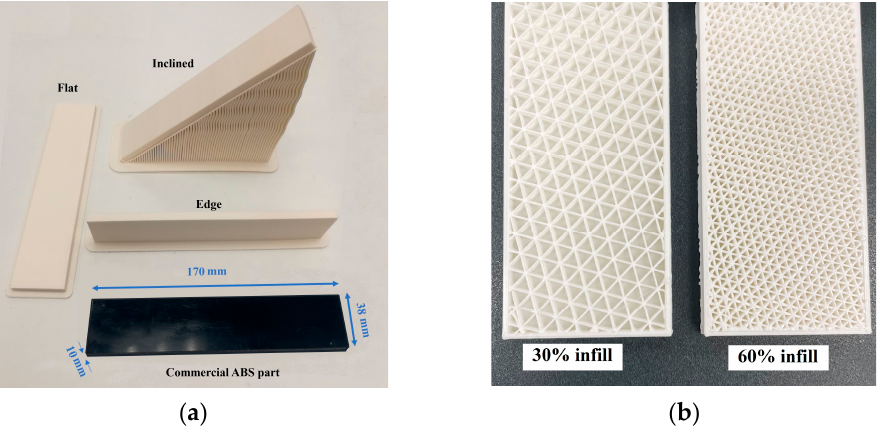
Figure 2. ABS test specimens: ( a ) solid parts; ( b ) parts with infills.